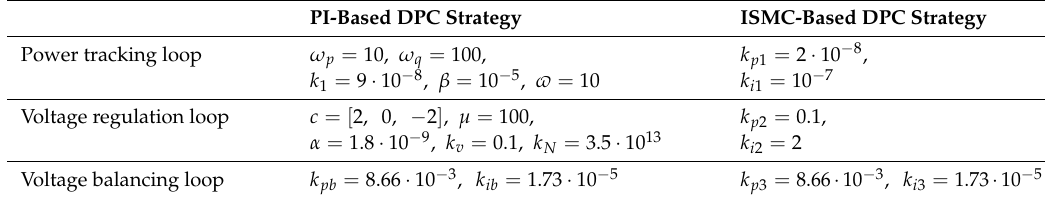
Table 3. Control parameters.